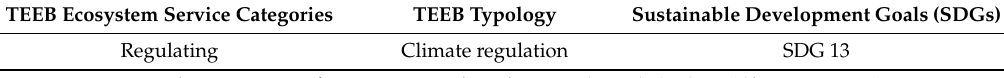
Table 1. Connections between regulating ecosystem services and selected Sustainable Development Goals (SDGs) in relation to atmospheric calcium and magnesium deposition for potential soil inorganic carbon (SIC) sequestration (adapted from Wood et al., 2017 [3]).